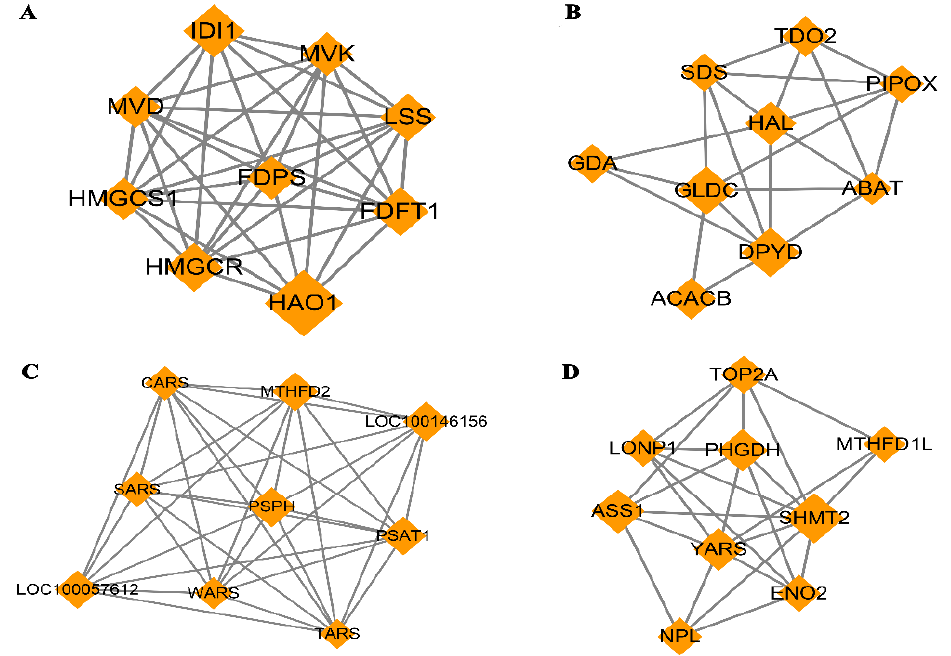
Figure 8. Four modules extracted from Protein–Protein Interaction (PPI) Network. Orange diamond represents degree value; large diamond has higher degree value. ( A , B ) Significant clustered up- regulated genes from the PPI; ( C , D ) Significant clustered down-regulated genes from the PPI. Furthermore, the genes in the key modules were used for the GO enrichment